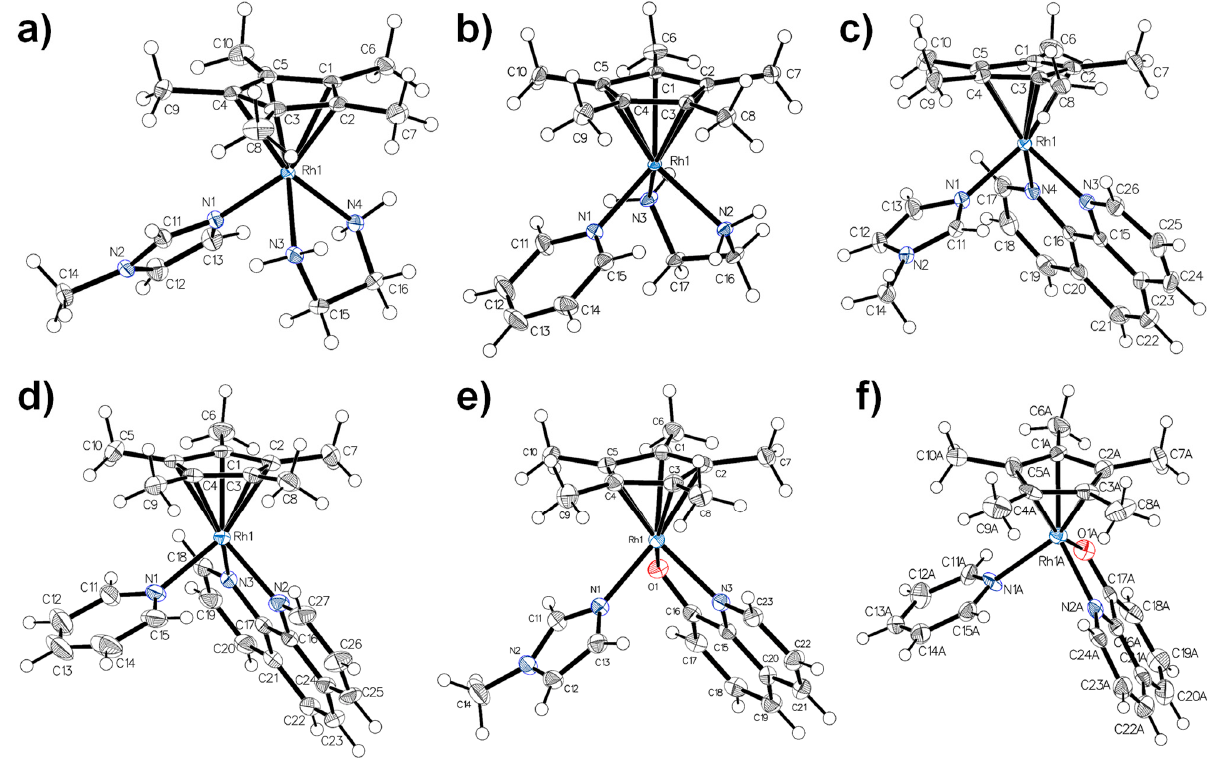
′ ), ( b ) [RhCp*(en)(Py)](CF 3 SO 3 ) 2 ′ ′ ), ( d ) [RhCp*(phen)(Py)](CF 3 SO 3 ) 2 × CH 3 OH ( 4 ), ′ ′ ), and ( f ) [RhCp*(8HQH ‑1 )(Py)](BPh 4 ) ( 6 ). Solvent ◦ ′ ′ ) in complexes 1 –6 . Values in parenthesis are the